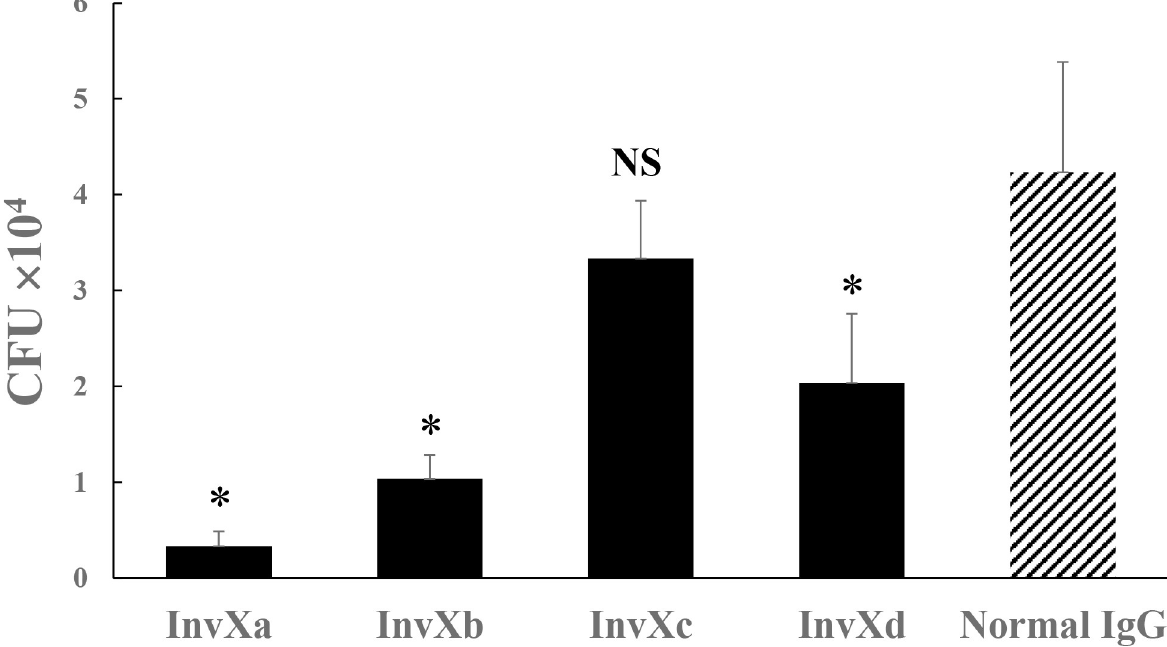
Fig 7. Inhibitory effects on anti-InvX Abs raised against each set of synthetic peptide corresponding to an InvX divided region on the nasal epithelial cells invasion by InvX expressing E . coli . UT4400/pMK invX E . coli strain were pretreated overnight with resultant Abs and normal IgG as a control. Each Ab preparation was added to monolayer RPMI2650 cells and incubated for 3 h. After washing, GM was added to eliminate bacteria outside the cells. Bars represent mean ± standard deviation CFU of UT4400/pMK invX E . coli treated with Abs. The invasive activity was suppressed by Abs against InvXa, InvXb, and InvXd. Asterisks indicate p < 0.05, NS: Not significant (Dunnet test). Bars represent the mean ± SD of intracellular bacteria in CFU in a triplicate representative experiment performed in three experiments. Asterisks indicate a significant difference compared with an IgG